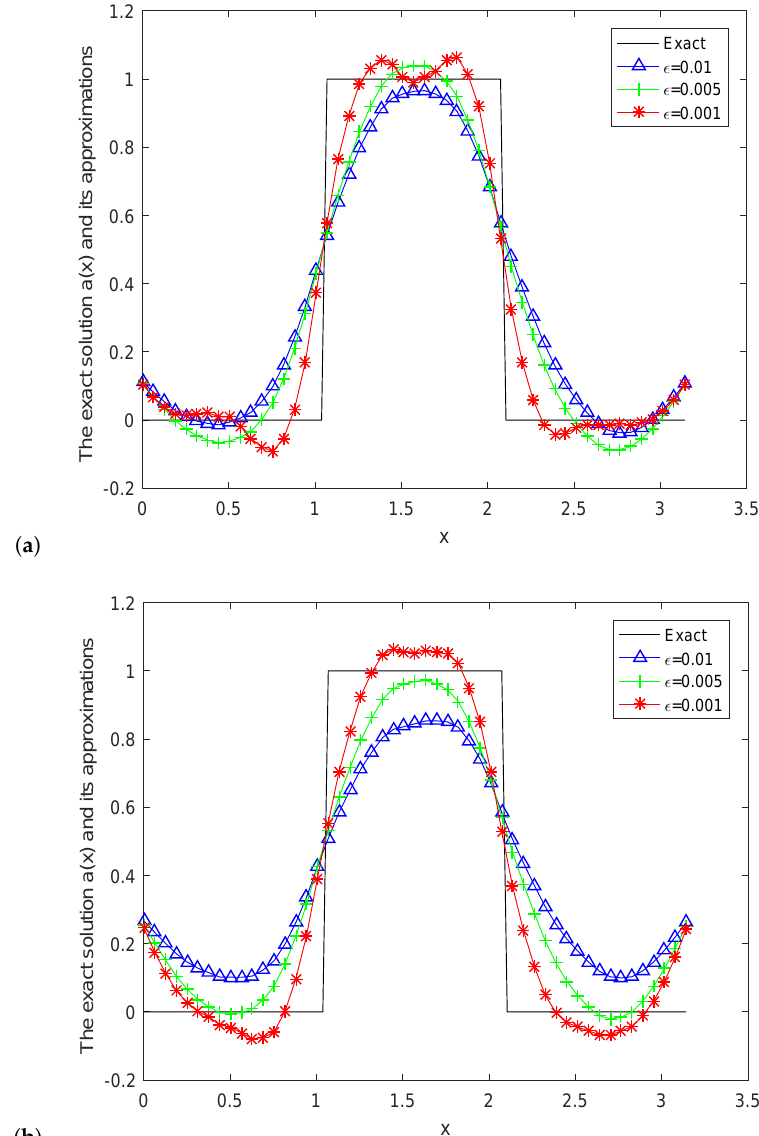
( x ) for Instance 3: ( a ) α = 1.2, ( b ) N 1